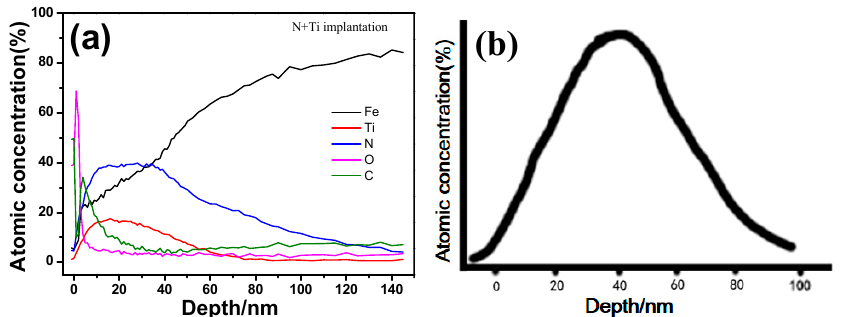
Figure 6. ( a ) The distribution of atomic concentration along the depth of N + Ti implanted sample and ( b ) corresponding stimulation results of Ti implanted in the M50 substrate (parameters for simulation as same as real implantation: Energy: 90 keV, 60 keV and 40 keV at 45 kV, 30 kV and 20 kV of accelerating voltage; implantation dose: 2 × 10 17 ions/cm 2 ). Figure 7a shows the O 1s X-ray photoelectron spectra (XPS) at different implantation depths. It indicates that the peak intensity of oxygen was at its maximum at 3 nm, and beyond the thickness of 20 nm, O 1s peak became very weak. At a depth of 3 nm, the two peaks at 530.07 and 531.4 eV corresponded to FeO and TiOx, respectively. The peak due to TiO 2 disappeared beyond 60 nm, consistent with the depth distribution of the Ti element in the AES results. Oxides were not found in the XRD results, which may be related to the amorphous state.